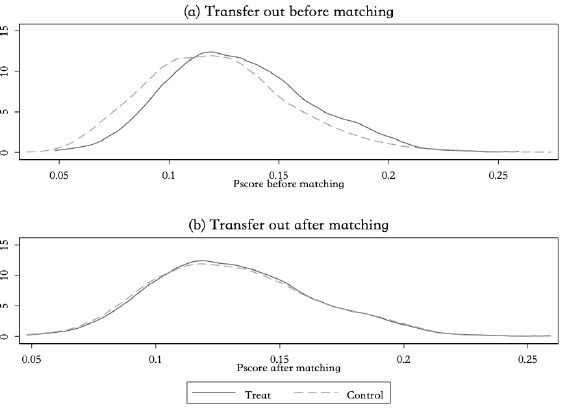
Figure 1. Common support assumption test for transferring-in land density distribution of p-scores before and after matching. (a) Transferring in before matching; (b) Transferring in after matching.